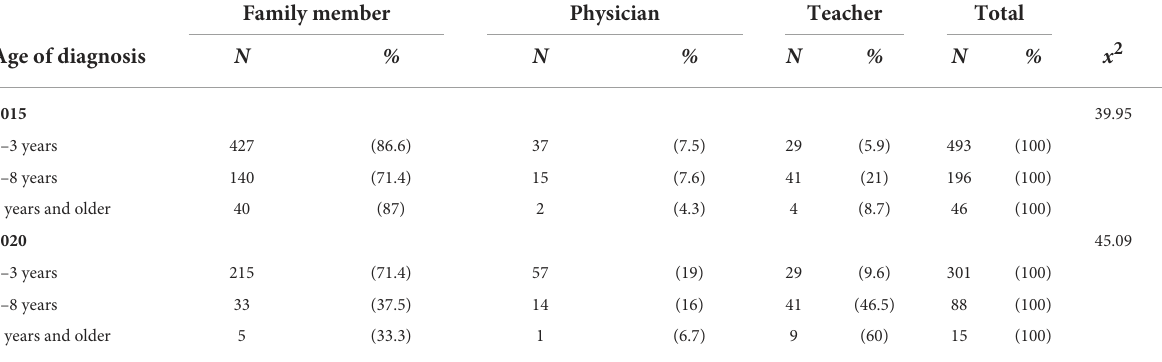
TABLE 4 Age of diagnosis and person who first noticed developmental